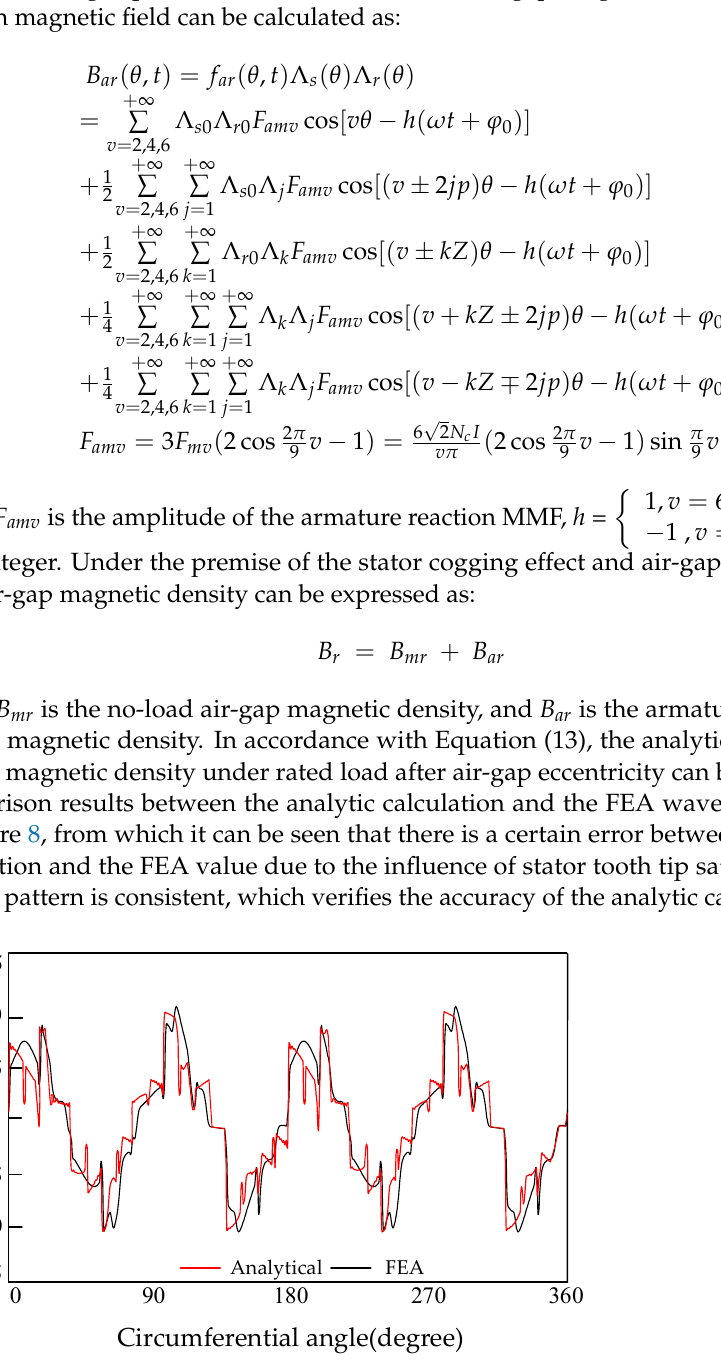
( b ) Figure 9. Harmonic distribution of radial and tangential air-gap magnetic density: ( a ) the amplitude of the radial air-gap magnetic density; ( b ) the amplitude of the tangential air-gap magnetic density.